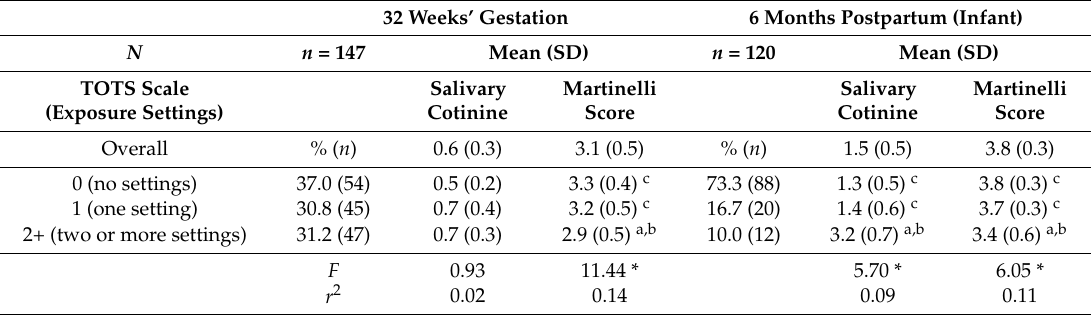
Table 2. Frequency and percentage of the participants, the mean and standard deviation of salivary cotinine, and the Martinelli scores of non-smoking control group participants with salivary cotinine ≤ 10 µ g/mL by reported exposure (TOTS) at 32 weeks’ gestation and 6 months postpartum. 32 Weeks’ Gestation 6 Months Postpartum (Infant) N n = 147 Mean (SD) n = 120 Mean (SD) TOTS Scale Salivary Martinelli Salivary Martinelli (Exposure Settings) Cotinine Score Cotinine Score Overall % ( n ) 0.6 (0.3)